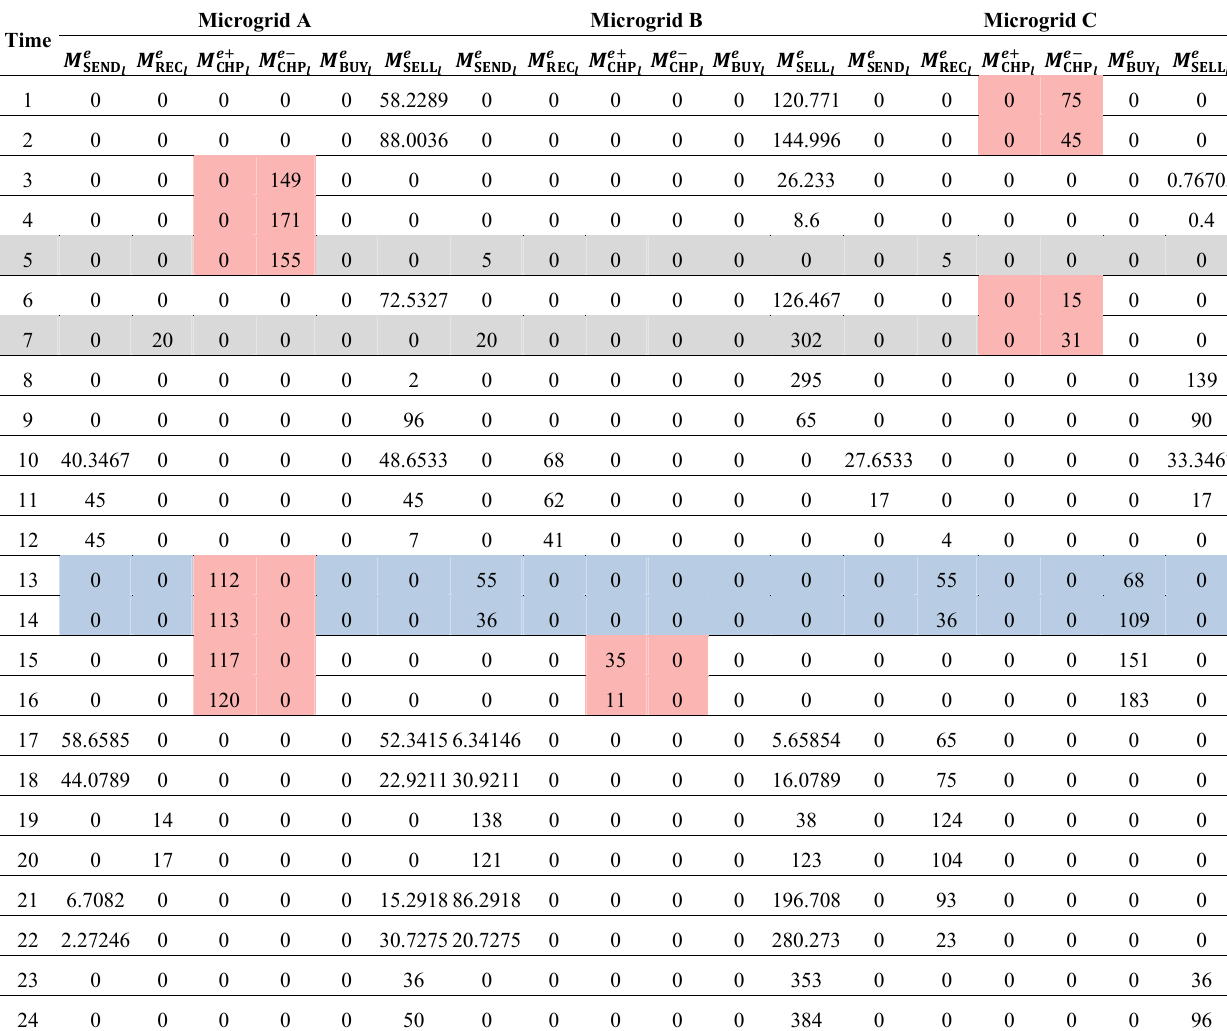
Table 2. Optimal global operation results from Step 2.